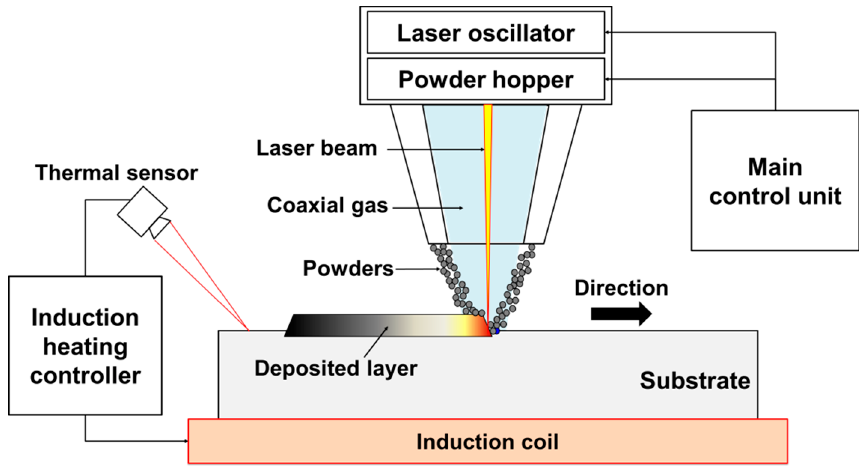
Figure 2. Schematic of the DED (direct energy deposition) process. Table 2. Processing parameters used.